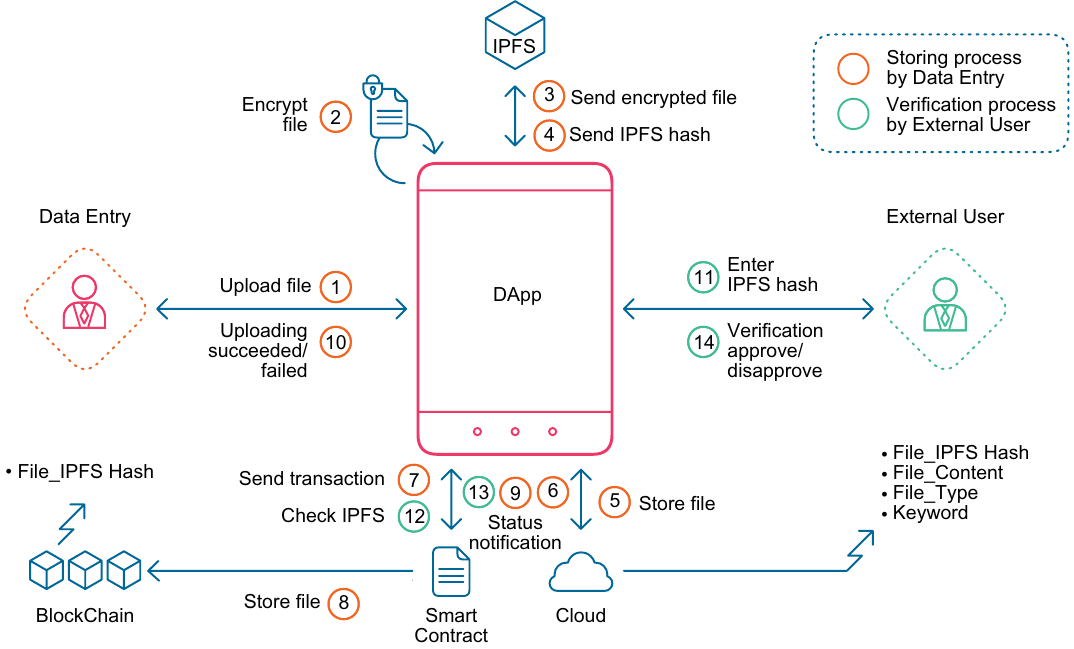
Figure 1. The system architecture of the file storing process conducted by the medical user and the verifying file process conducted by the external user. Several components are used to perform these two functions: SVBE DApp, IPFS, cloud, and blockchain. The stored data are kept in the cloud and blockchain